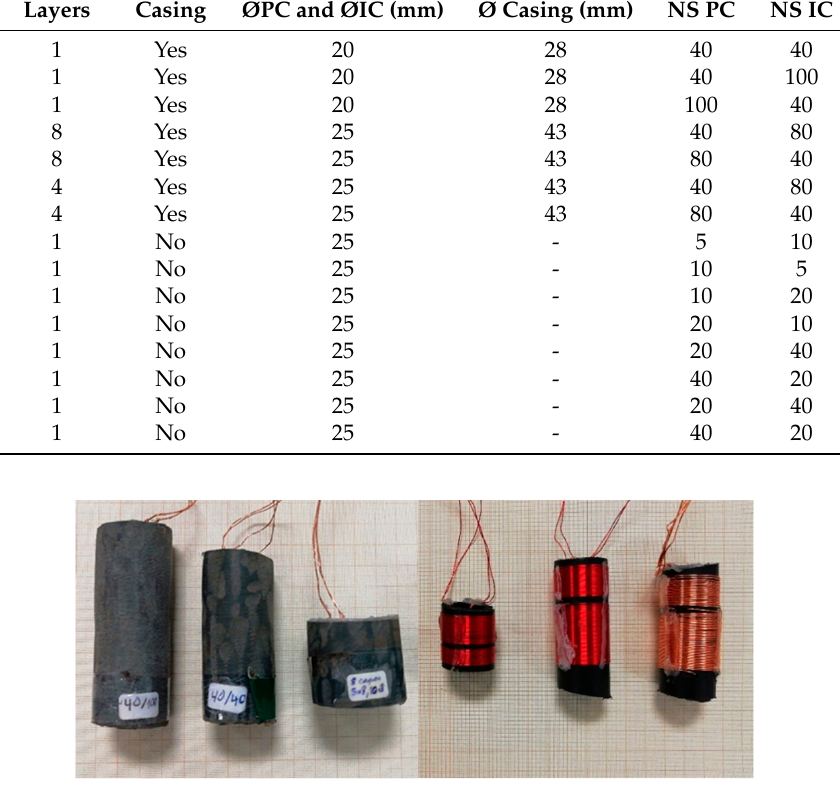
Figure 2. The covered and the uncovered prototypes. Table 1. Features of the different prototypes for the initial tests.